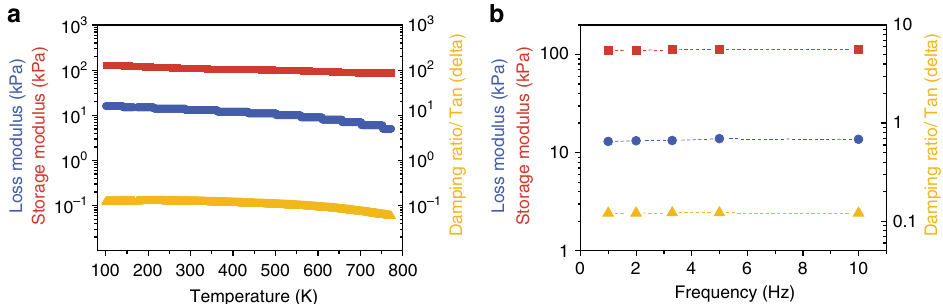
Fig. 3 Mechanical stability of bCAs. a , b Storage modulus (red), loss modulus (blue), and damping ratio (yellow) as function of temperature ( a ) and frequency ( b ) of bCAs with 30 wt%